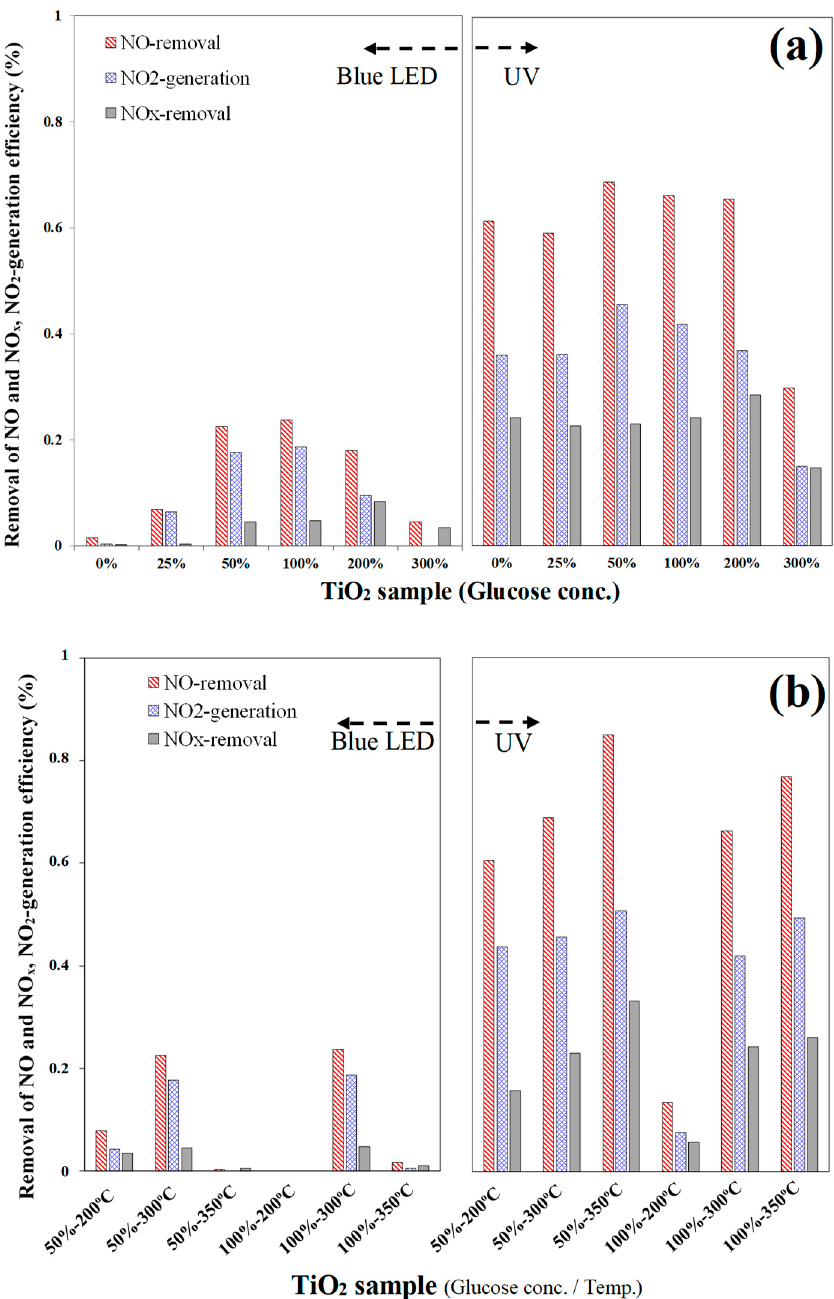
Figure 2. Average NO x removal efficiency of various C–TiO 2 photocatalysts under UV and visible-light irradiations, showing the changes with ( a ) glucose concentrations and ( b ) calcination temperatures; sample size: 8 × 10 cm 2 , inlet concentration of NO: 1.00 ppm, inlet flow rate: 1 L/min, irradiation intensity of visible and UV light: 1.33 and 2.50 mW/cm 2 , respectively, reaction temperature: 20 ◦ C, relative humidity: